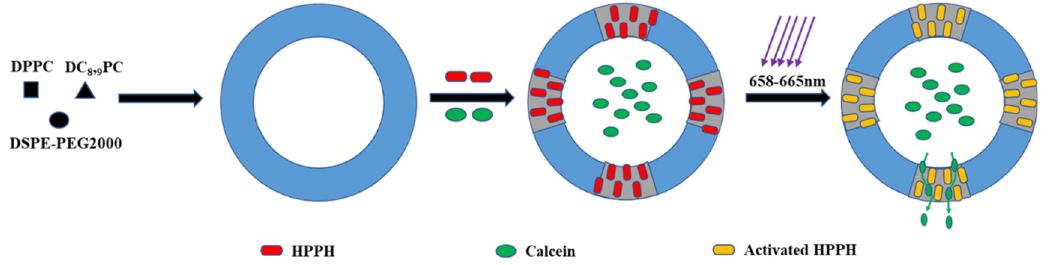
Figure 4. Design consideration of light-responsive liposomes.